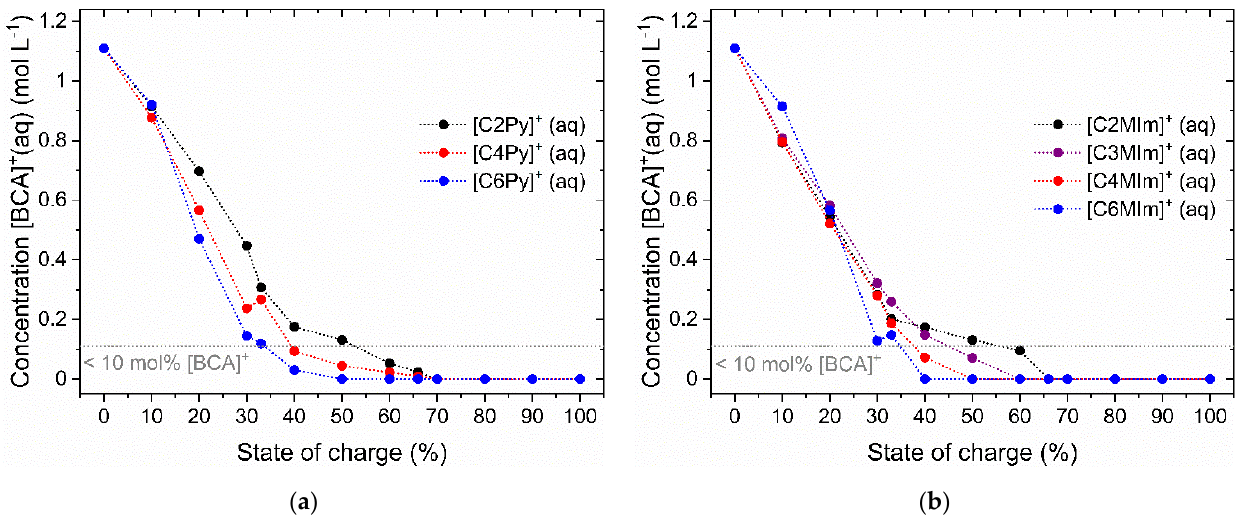
Figure 5. Concentration of [BCA] + cations in the aqueous electrolyte phase containing ( a ) 1-alkylpyridine-1-ium bromides and ( b ) 1-alkyl-3-methylimidazole-1-ium bromides used as BCAs with different alkyl radicals in N-position as a function of the state of charge (SoC). All values of Figure 5 are printed in the SM in Table S1.